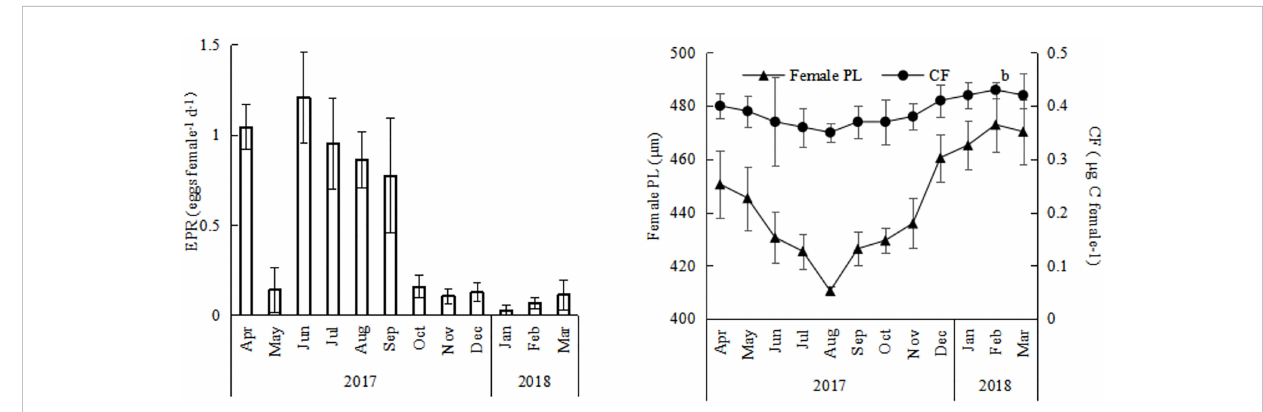
FIGURE 5 Annual variations of EPR, female PL, CF of Oithona similis in Jiaozhou Bay, vertical bars represent standard deviation (SD).